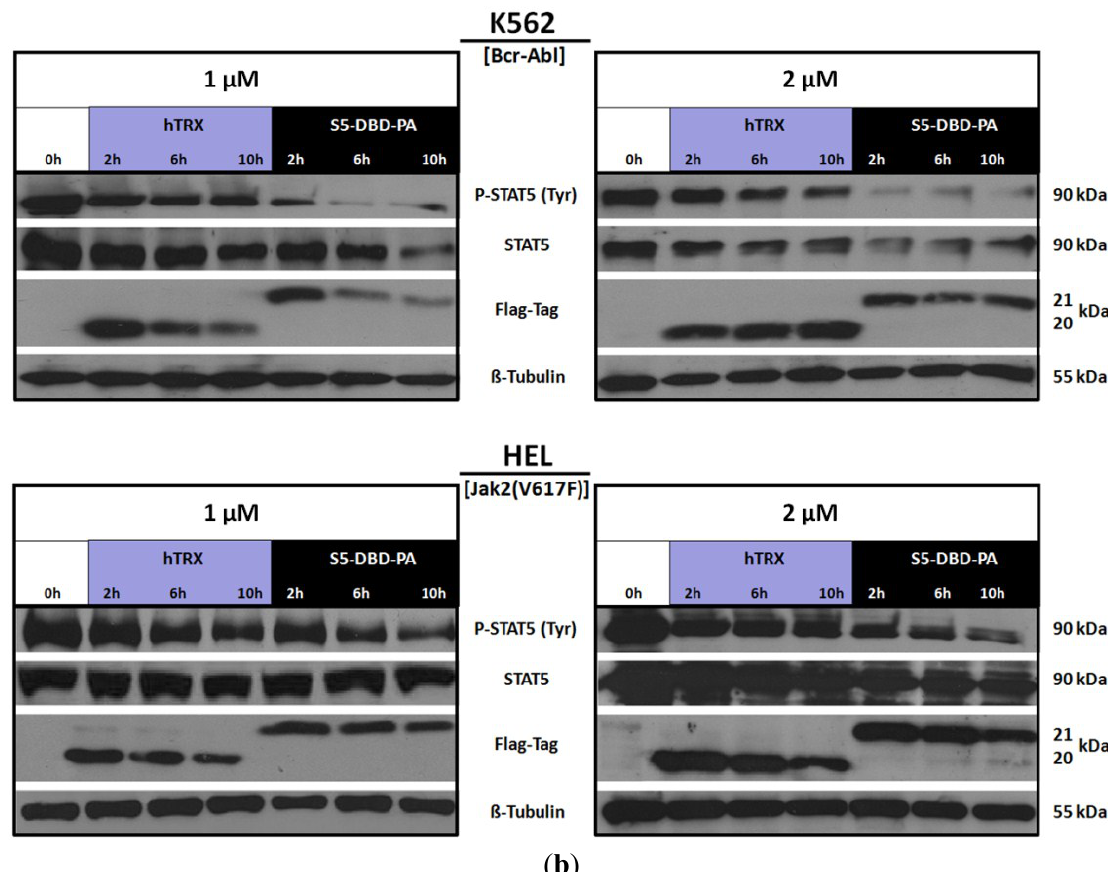
Figure 5. The interaction of S5-DBD-PA with the DBD of Stat5 inhibits nuclear translocation of activated dimers of Stat5 in K562 cells and enhances Stat5 degradation. ( a ) Recombinant S5-DBD-PA and hTRX were added to the culture media of K562 and HEL cells (f.c.: 2 µM). After 4 h incubation, membrane bound proteins were removed by acid-wash and cytosolic and nuclear fractions were prepared. Cell fractions subsequently were analyzed by western blotting with antibodies detecting Flag-tagged recombinant proteins, total Stat5 and tyrosine phosphorylated, P-Stat5. Antibodies recognizing the cytosolic markers MEK1/2 and β-Tubulin and antibodies directed against nuclear Lamin B were used to monitor the quality of the subcellular fractionation. The treatment with PBS or protein solvent served as negative controls; ( b ) Cellular uptake of recombinant S5-DBD-PA by protein transduction. K562 and HEL cells were seeded in culture media supplemented with S5-DBD-PA or the hTRX scaffold control protein (f.c.: 1 and 2 µM). Cells were lysed after 2, 6 and 10 h. Non-transduced, membrane-bound proteins were removed for accurate measurement. Recombinant protein uptake and Stat5 were analyzed with a Flag-tag antibody and antibodies recognizing either Stat5 or